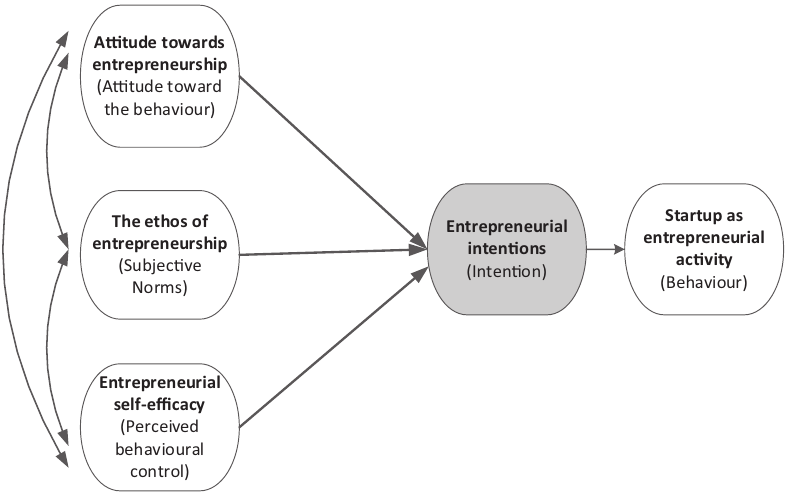
Figure 1. Adapted theory of the planned behaviour of Icek Ajzen (source: extended from Ajzen (1991, p. 182) and adapted by authors to the entrepreneurship